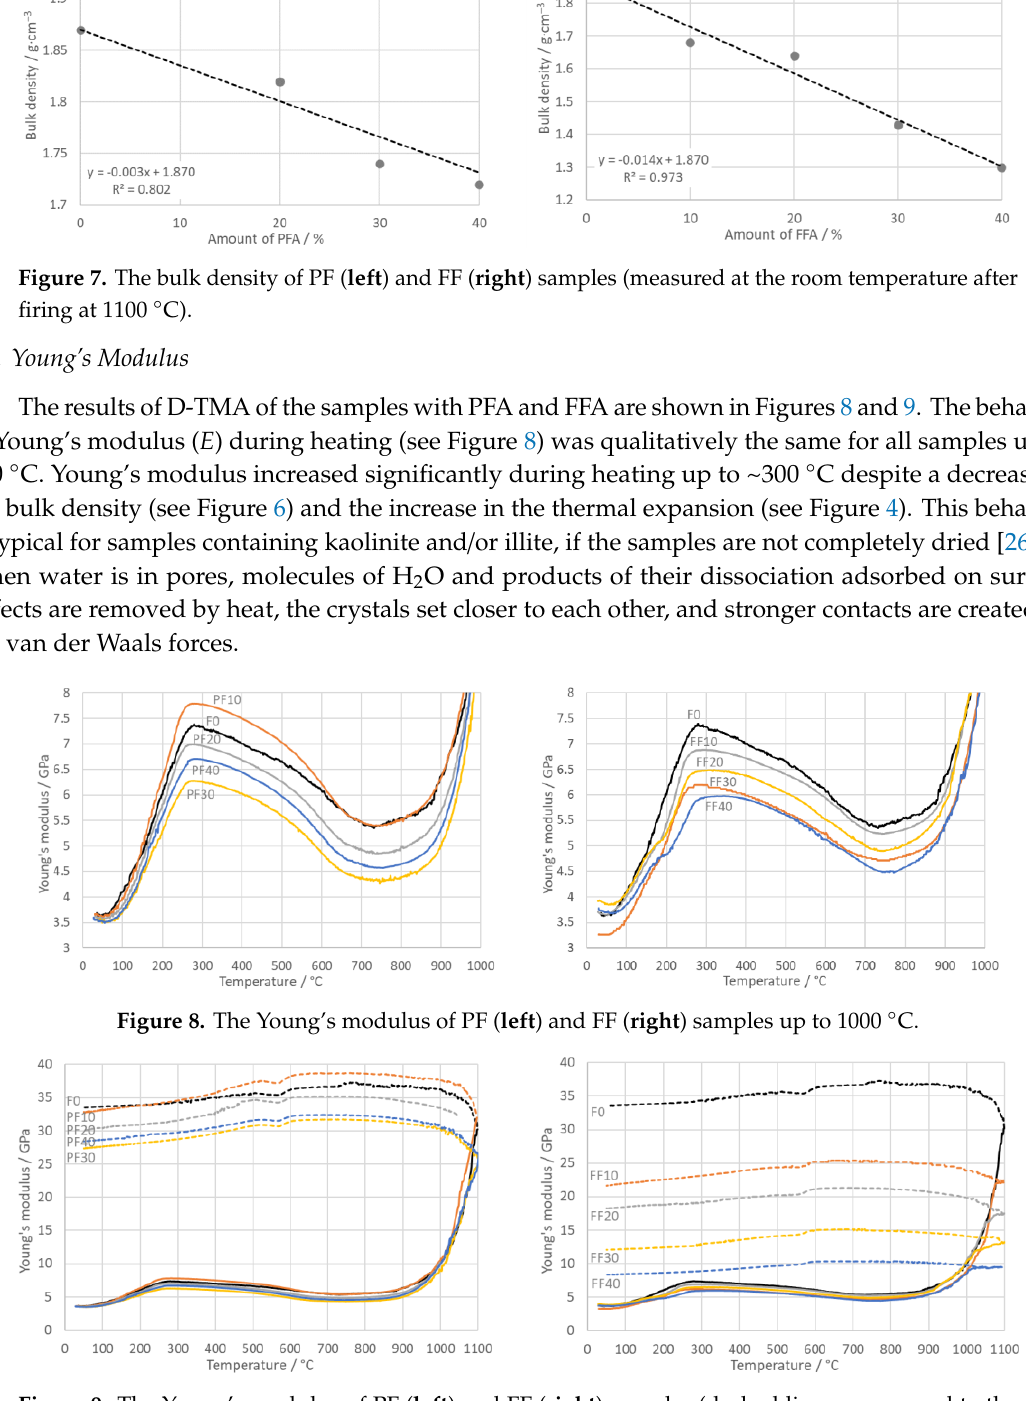
Figure 9. The Young’s modulus of PF ( left ) and FF ( right ) samples (dashed lines correspond to the cooling stage of the firing).